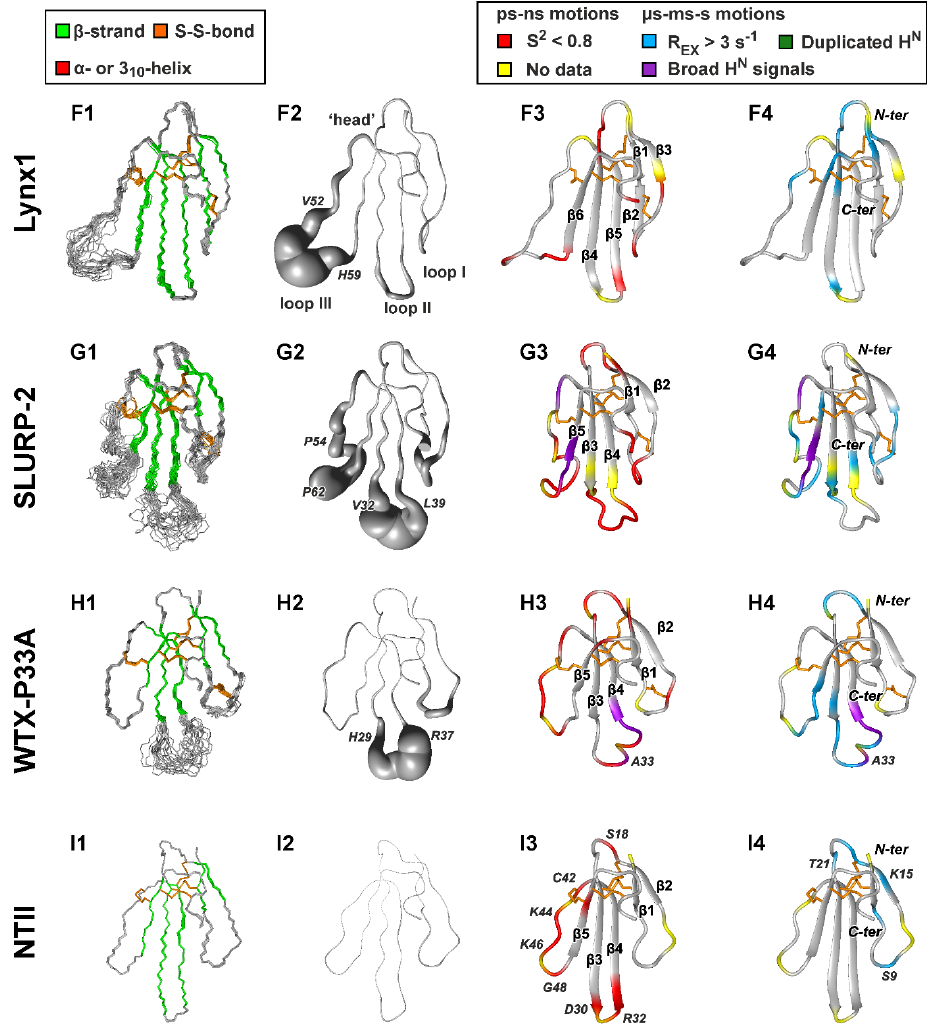
Figure 2. NMR structures and dynamics of TFPs: ( A ) trans -Tyr39-Pro40 SLURP-1, ( B ) cis -Tyr39-Pro40 SLURP-1, ( C ) Lypd6, ( D ) Lypd6b, ( E ) Lynx2, ( F ) Lynx1, ( G ) SLURP-2, ( H ) WTX-P33A, ( I ) NTII. For each protein/isomer, four panels are shown. (1) Set of the 20 best CYANA structures. Protein backbone and disulfide bonds (gold) are shown. Secondary structure elements are color-coded: red— α - or 3 10 -helix, green— β -sheet. (2) ‘Sausage’ representation of the mean structure with variable radius equal to the average displacement in the set of structures. In the Lypd6 and Lypd6b structures, the completely disordered C -terminal fragments (Leu85-Ala95) are omitted. (3–4). Ribbon representation of NMR structures with mapped data about ‘fast’ (ps–ns, 3) and ‘slow’ (µs-ms-s, 4) backbone dynamics. Regions with the high-amplitude ps–ns mobility (generalized order parameter S 2 < 0.8) are in red. Sites of µs-ms-s conformational fluctuations are in blue (exchange contributions to R 2 relaxation rates R ex > 3 s − 1 at 800 MHz), violet (significant broadening of 1 H N signals), and dark green (two protein conformers were observed). N -terminal Met0 residue, Pro residues, and the residues for which dynamics data are unavailable due to spectral overlap are highlighted by yellow. The residues from the disordered C -terminal fragments of Lypd6 and Lypd6b, which did not satisfactorily fit into any model of intramolecular mobility, are shown in red. Structural data for Lynx1, SLURP-2, WTX-P33A, and NTII were taken from previous publications [11,32,43,44]; other data are from the present